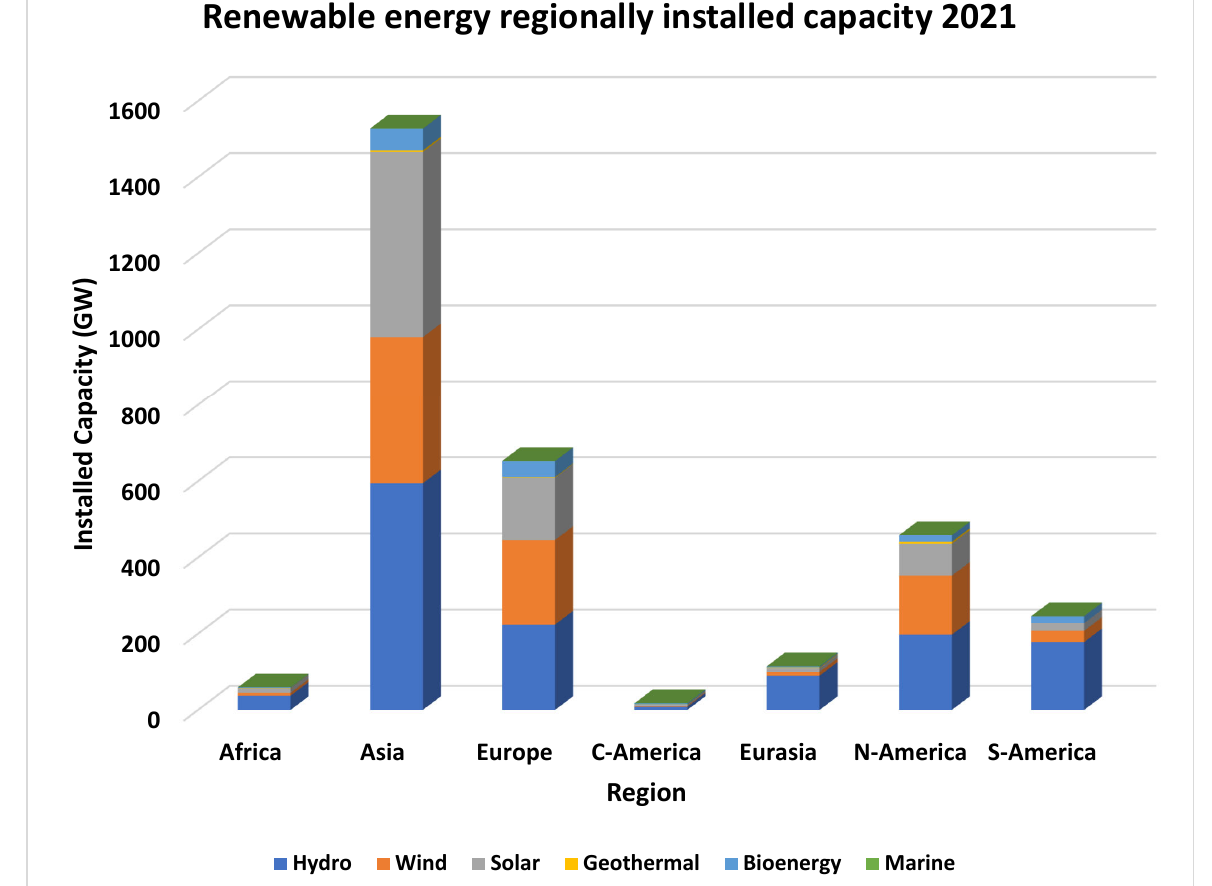
Figure 2. Different RER installed capacities according to regions.